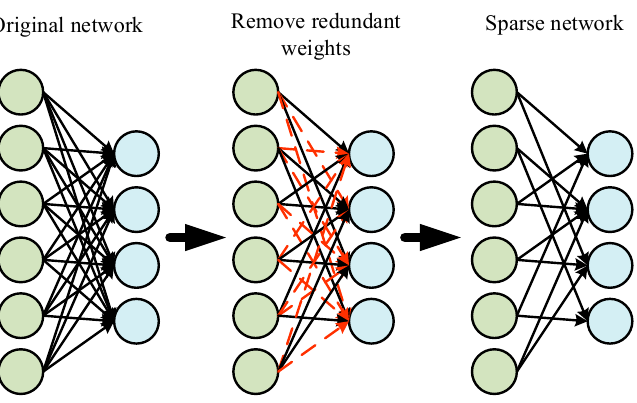
Figure 5. Neuronal changes before and after pruning.